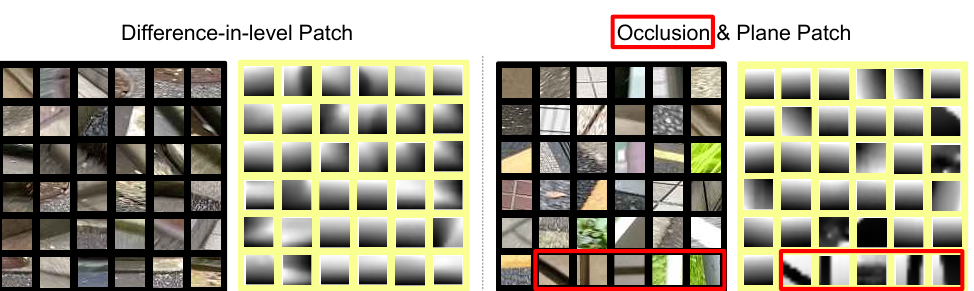
Figure 6. Difference-in-level areas.